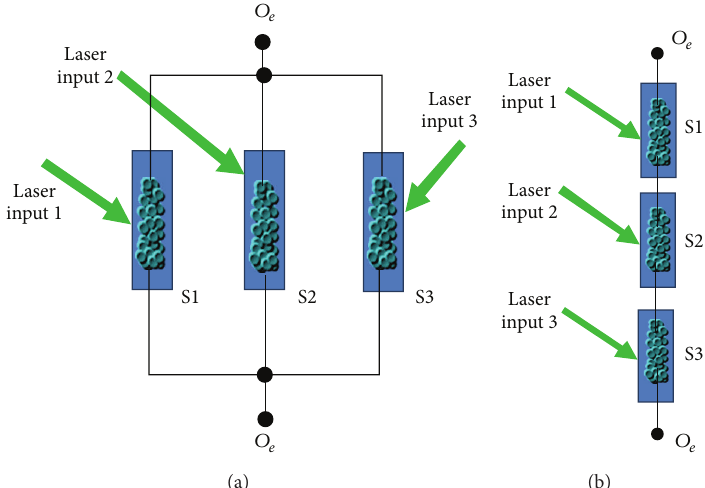
Figure 2: Schematic illustration of the setup for the photoconductive multiplexing system. (a) Parallel circuit. (b) Series circuit.